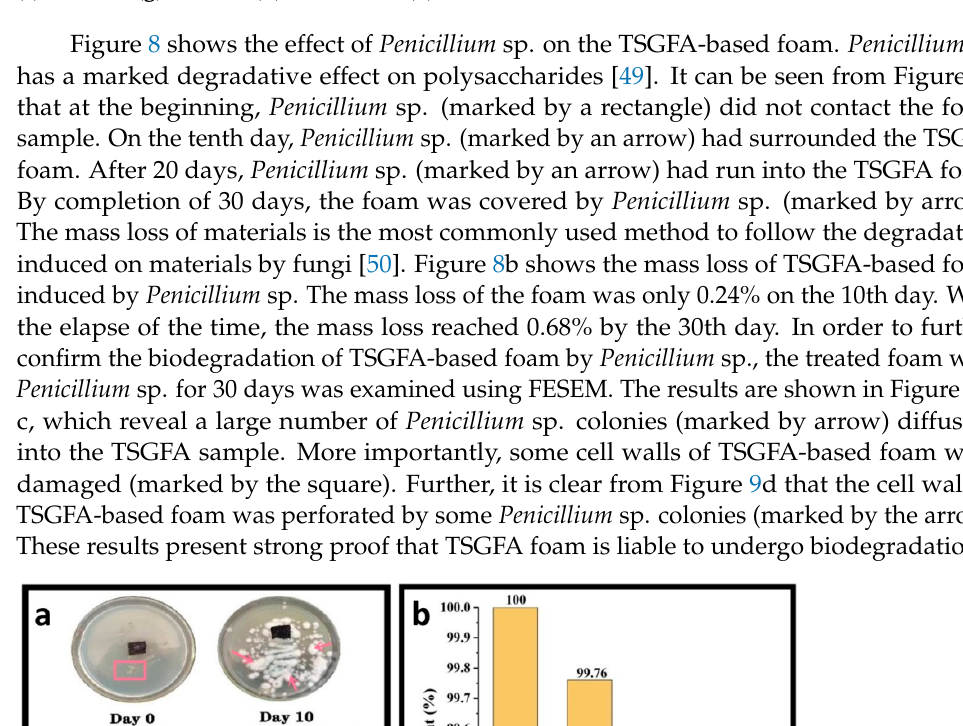
Figure 9. FESEM micrographs showing biodegradability profile of TSGFA-based foam, induced by Penicillium sp. colonies: Scale bar represents 500 µm for ( a – c ), and 10 µm in the case of ( d ). 4. Conclusions 1. Different bio-based foam structures in crosslinked form can be prepared from a polycondensation reaction incorporating starch, furfuryl alcohol, glyoxal, and condensed tannin under mild acidic conditions and an appropriate foaming agent. The selection of catalytic system and foaming agent determines, to a large extent, the cell formation characteristics of the foam structure, while the mechanical strength is a parameter that is dependent on the condensing agents’ formulation.